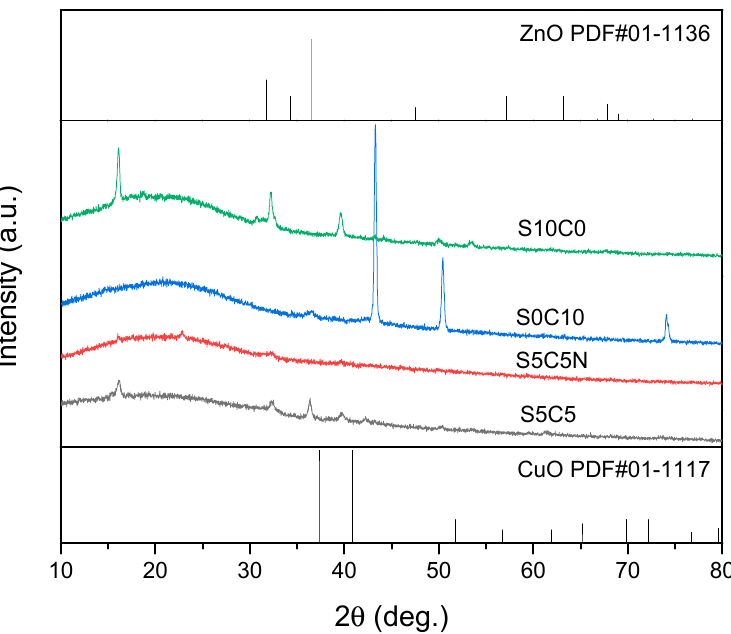
Figure 4. X-Ray diffraction patterns of hydrochar samples.